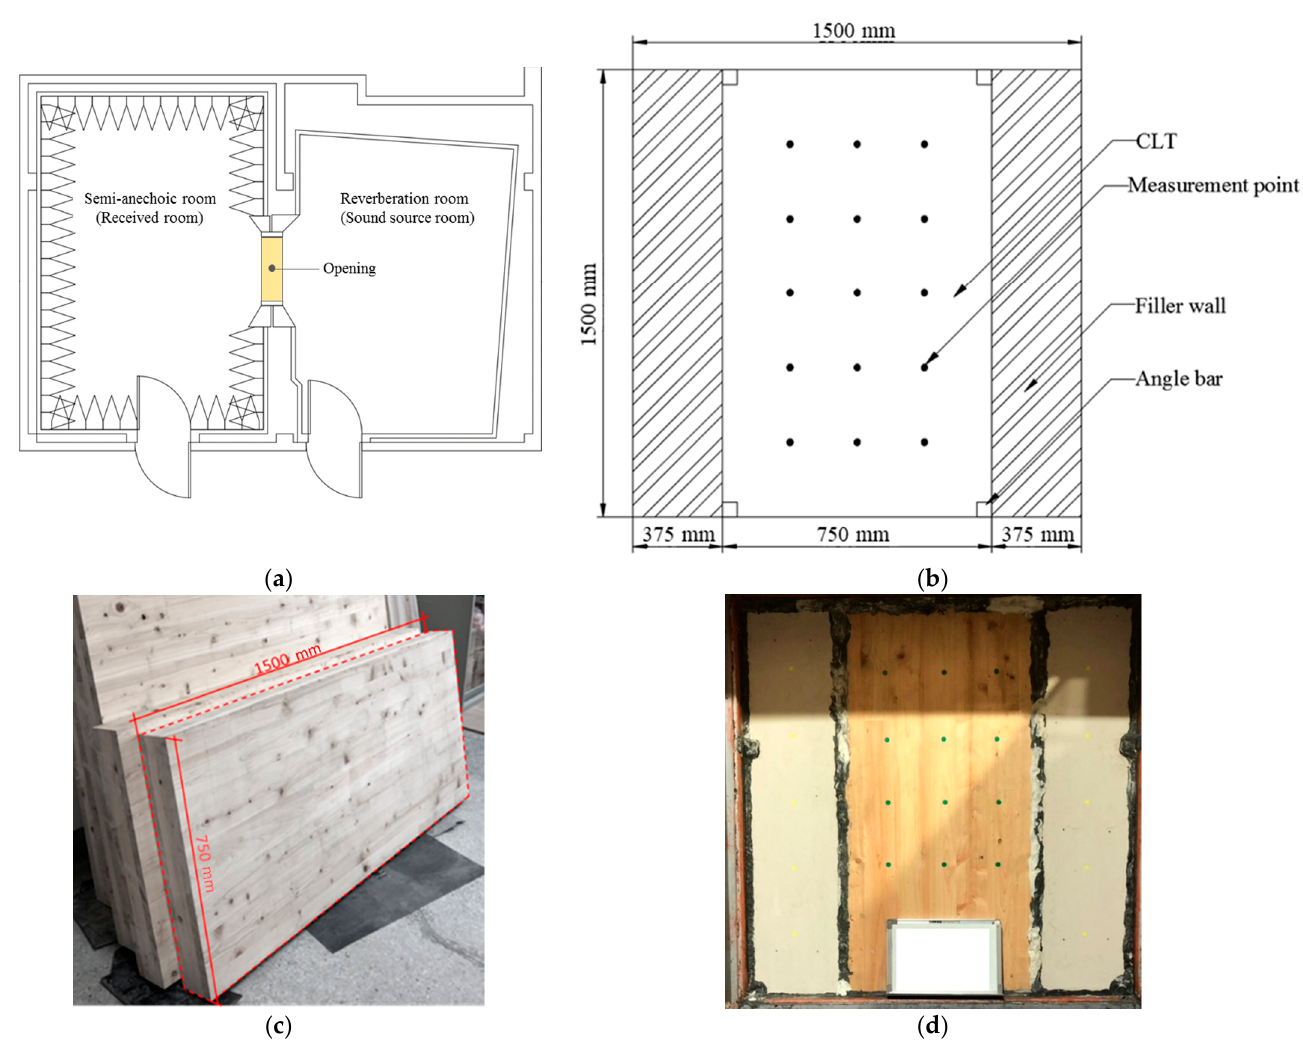
Figure 5. The installation of the test area and implementation. ( a )The specimen was implemented in the opening area, and the measurement area was 1.125 m 2 . ( b ) Evenly distributed measurement points. ( c ) The sample of CLT panel (dashed range). ( d ) The CLT was installed in the middle of the area.